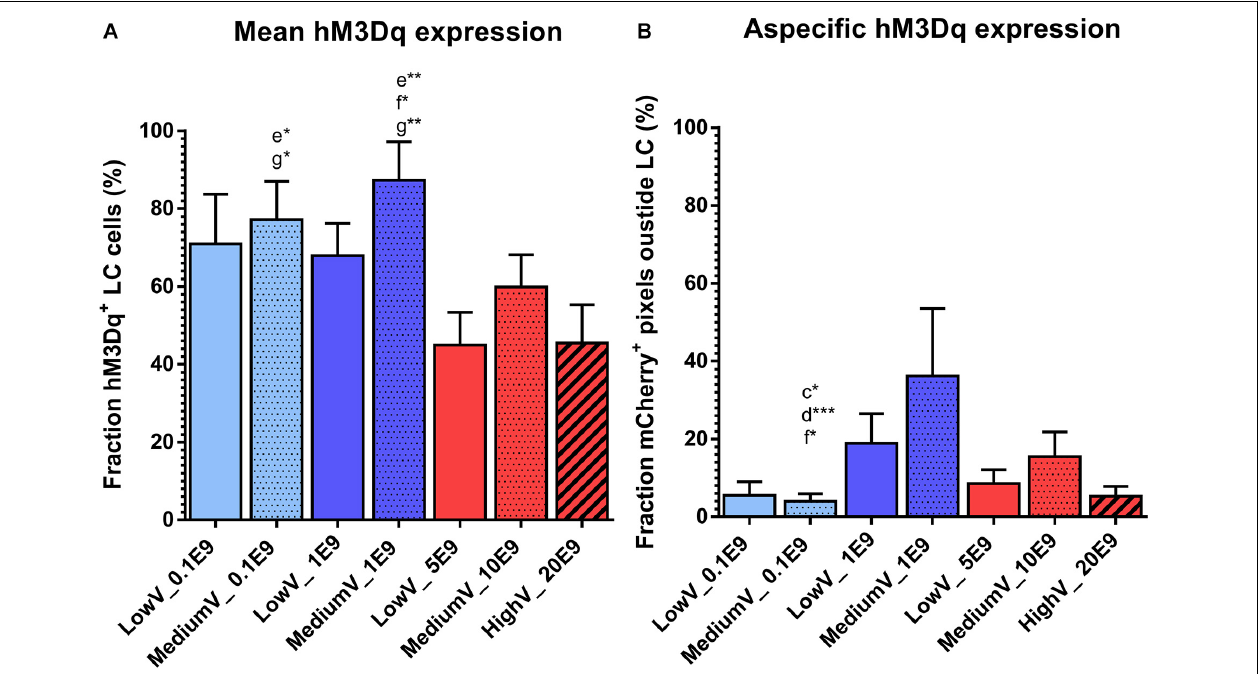
FIGURE 2 | Transduction efficiency of CAV2-PRSx8-hM3Dq-mCherry viral vector to express hM3Dq in LC. (A) Mean hM3Dq expression in DBH positive cells after manual cell count. MediumV_1E9 induces the highest level of hM3Dq expression compared to LowV_5E9, MediumV_10E9, and HighV_20E9. MediumV_0.1E9 condition shows similar levels, significantly higher compared to LowV_5E9 and HighV_20E9. (B) Mean aspecific hM3Dq expression. In the MediumV_0.1E9 condition the lowest level of aspecific expression is observed compared to LowV_1E9, MediumV_1E9 and MediumV_10E9. GLM negative binomial statistical analysis showed that the chance of an mCherry + pixels detected outside LC is, respectively, 4.8, 9.1, and 3.9 times higher in the LowV_1E9, MediumV_1E9 and MediumV_10E9 condition compared to MediumV_20E9. Bars represent the mean ± SEM per condition. Pattern inside the bars represent the injected volume: low, 3 × 300 nl = no pattern; medium, 3 × 600 nl = dotted pattern; high, 3 × 1200 nl = striped pattern. Colors of the bars represent the dilution: undiluted (5,10,20E9 pp) = red; diluted to 1E9 pp = dark blue; diluted to 0.1E9 pp = light blue. Letters above the bar represent significant difference with the corresponding condition (a: the first bar from the left, in alphabetical order with the last bar being g). Stars added to the letters indicate the level of significance (* p < 0.05; ** p < 0.01, *** p <